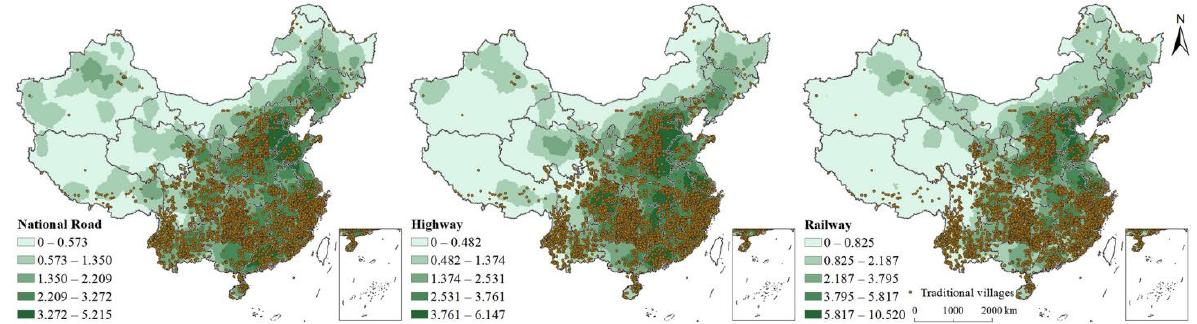
Figure 5. Spatial relationships between the distribution of traditional villages and locations. Population Size